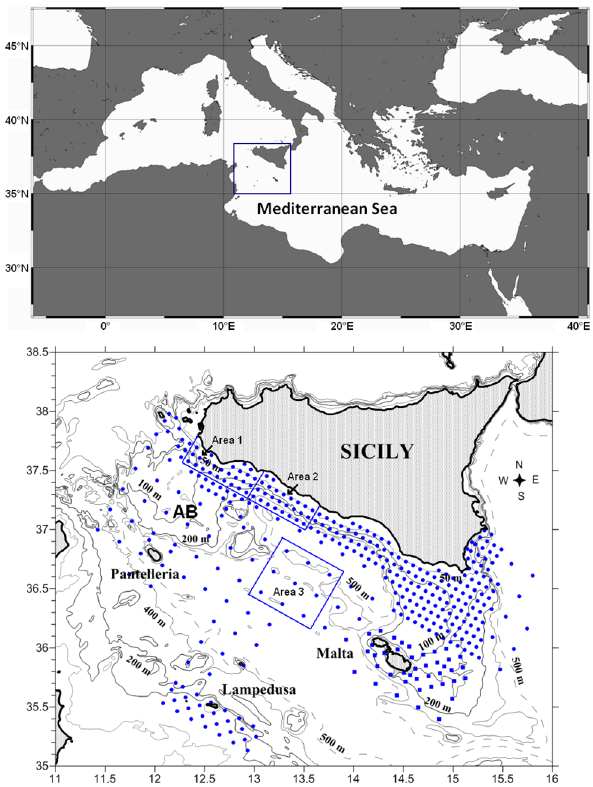
Figure 1. The study area in the Strait of Sicily and the overall sam- pling design adopted in the period 1998–2013 (blue dots); the Mal- tese waters are investigated since 2004 (blue squares). Upwelling areas (1 and 2) and the control area (3) are identified by three rect-